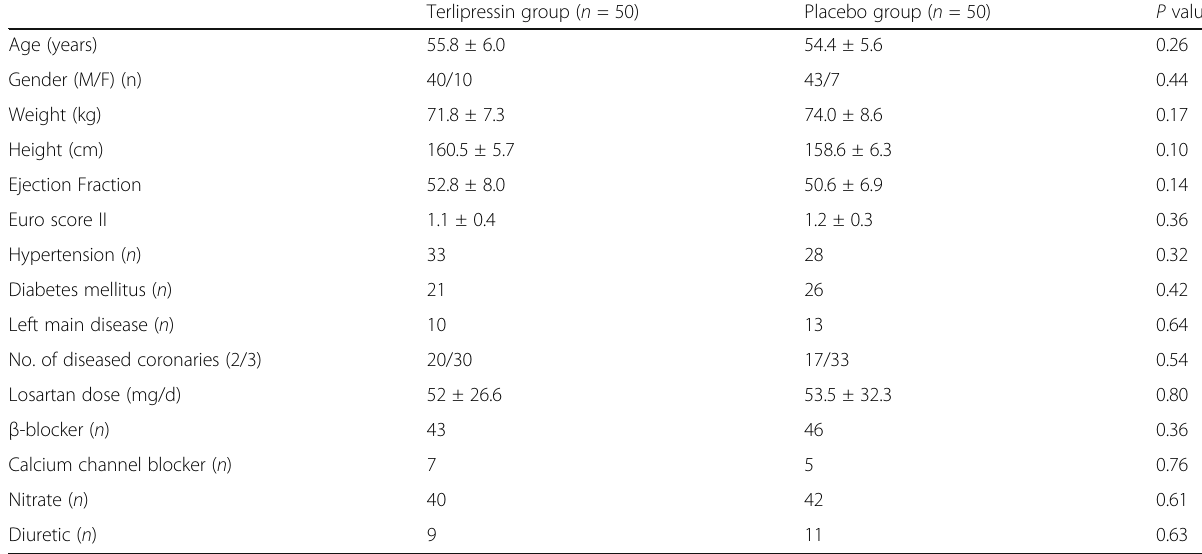
Table 1 General characteristics, clinical preoperative data, and preoperative medication Terlipressin group ( n = 50)